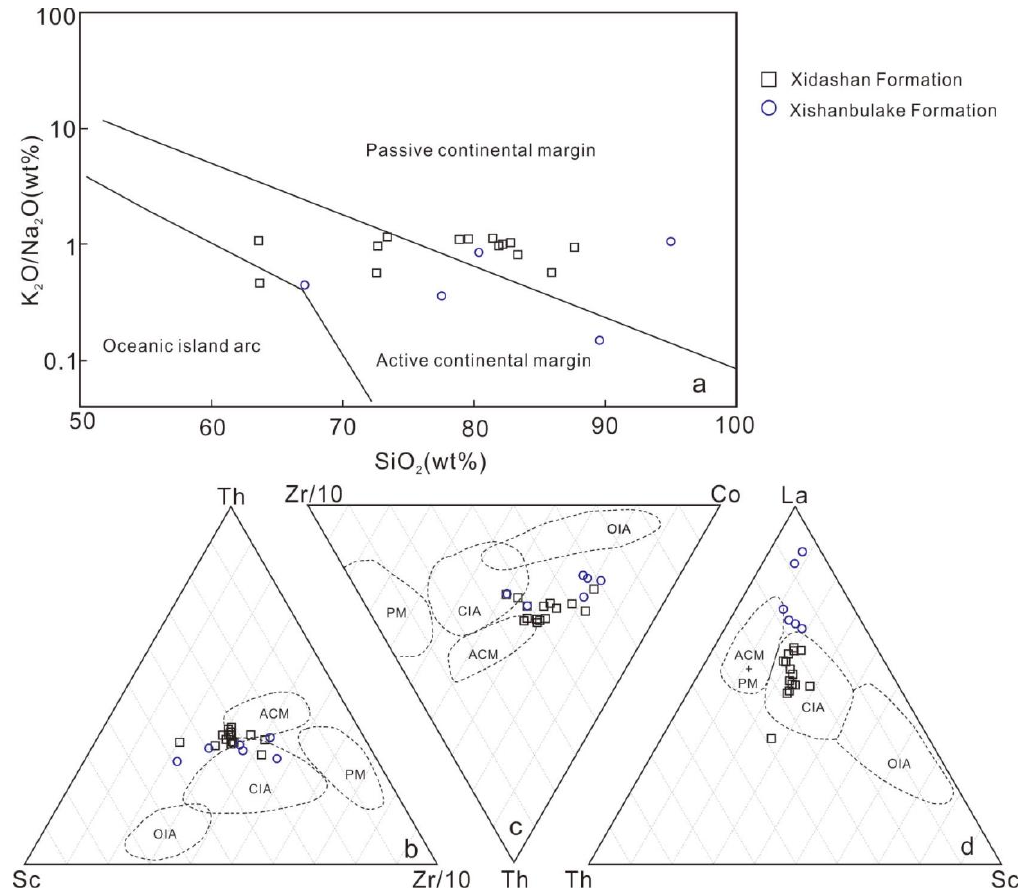
Figure 7. Tectonic discrimination plots for mudstones of the Lower Cambrian mudstones (after Roser and Koesch [37], 1986; Bhatia and Crook, 1986 [38]). ( a ) K 2 O/Na 2 O-SiO 2 discrimination diagram; ( b ) Th-Sc-Zr/10 discrimination diagram; ( c ) Th-Co-Zr/10 discrimination diagram; ( d ) La-Th-Scdiscrimination diagram. OIA — oceanic island arc; CIA — continental island arc; ACM — active continental margin; PM — passive margin.